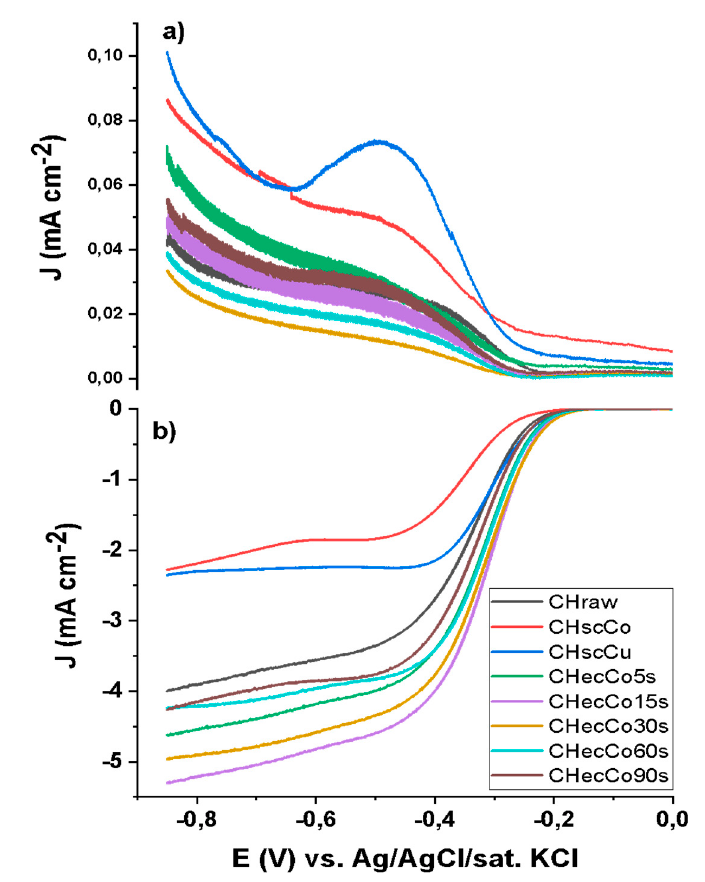
Figure 1. ORR RRDE electrocatalytic performance of samples obtained from sonochemical and electrochemical deposition of Co and Cu on CHraw : ( a ) ring; and ( b ) disk density of current.